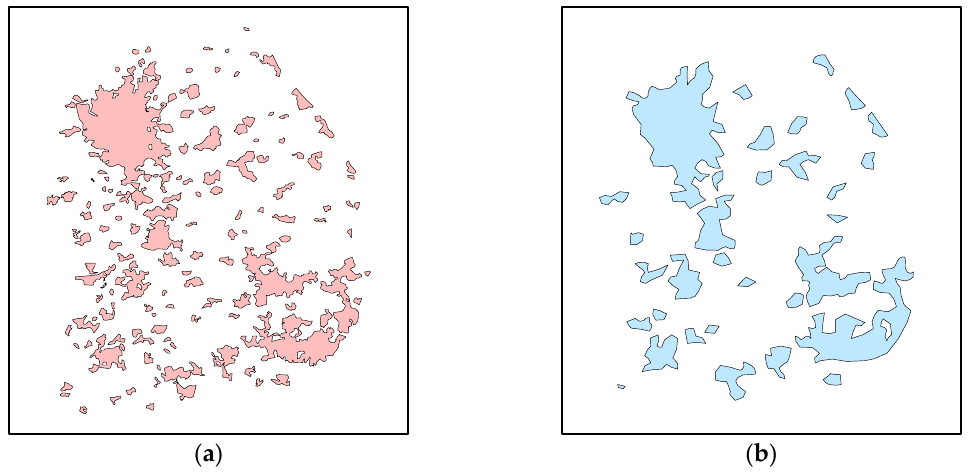
Figure 13. Urban area datasets in different scales: ( a ) dataset A in scale of 1:100,000 and ( b ) dataset B in scale of 1:500,000.